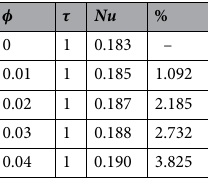
Table 2. Variation in Nusselt number in response to volume fraction of gold